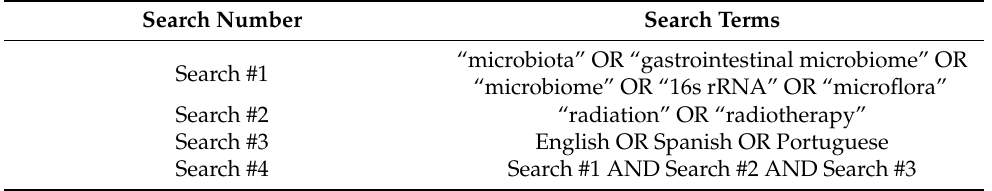
Table 2. Literature search algorithm—EMBASE (via